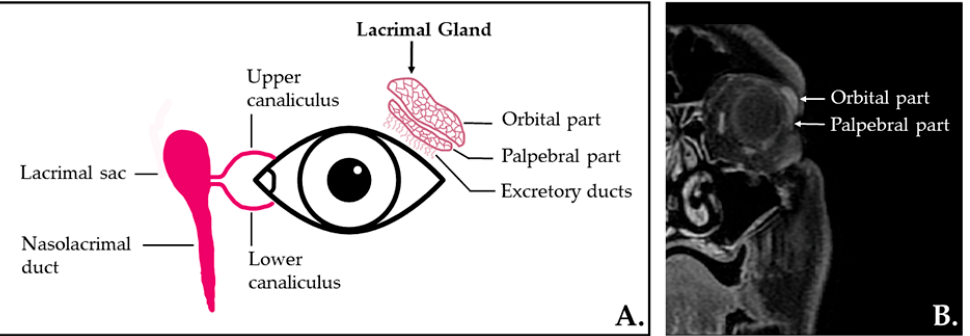
Figure 1. ( A ) The lacrimal apparatus anatomy—illustration. ( B ) Coronal contrast-enhanced T1- weighted MR image with fat saturation depicting the normal aspect of the lacrimal gland localized in the superolateral region of the orbit (extraconal) and its lobe divisions.